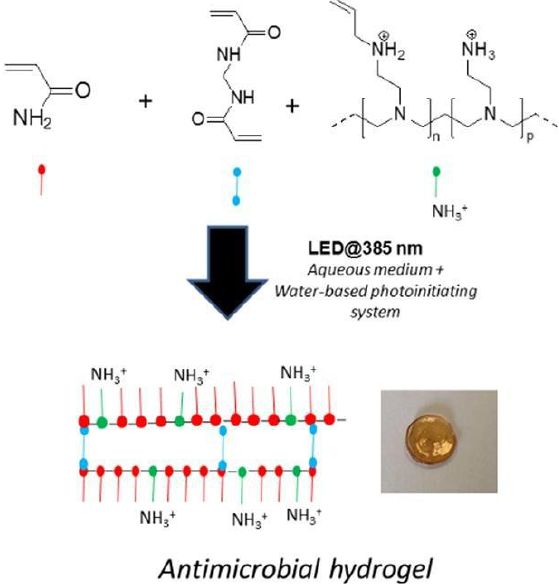
Figure 7. Schematic illustration of the photoinduced crosslinking between acrylamide, bisacrylamide and allylated poly(ethyleneimine) forming an antibacterial hydrogel. Reprinted with permission. Copyright 2020, Elsevier [61].